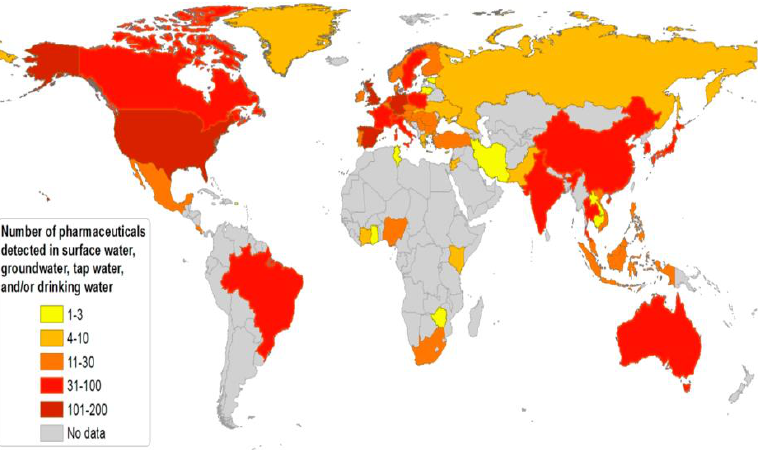
Figure 1. Number of pharmaceutical compounds detected in surface, ground and drinking water systems in worldwide [4].